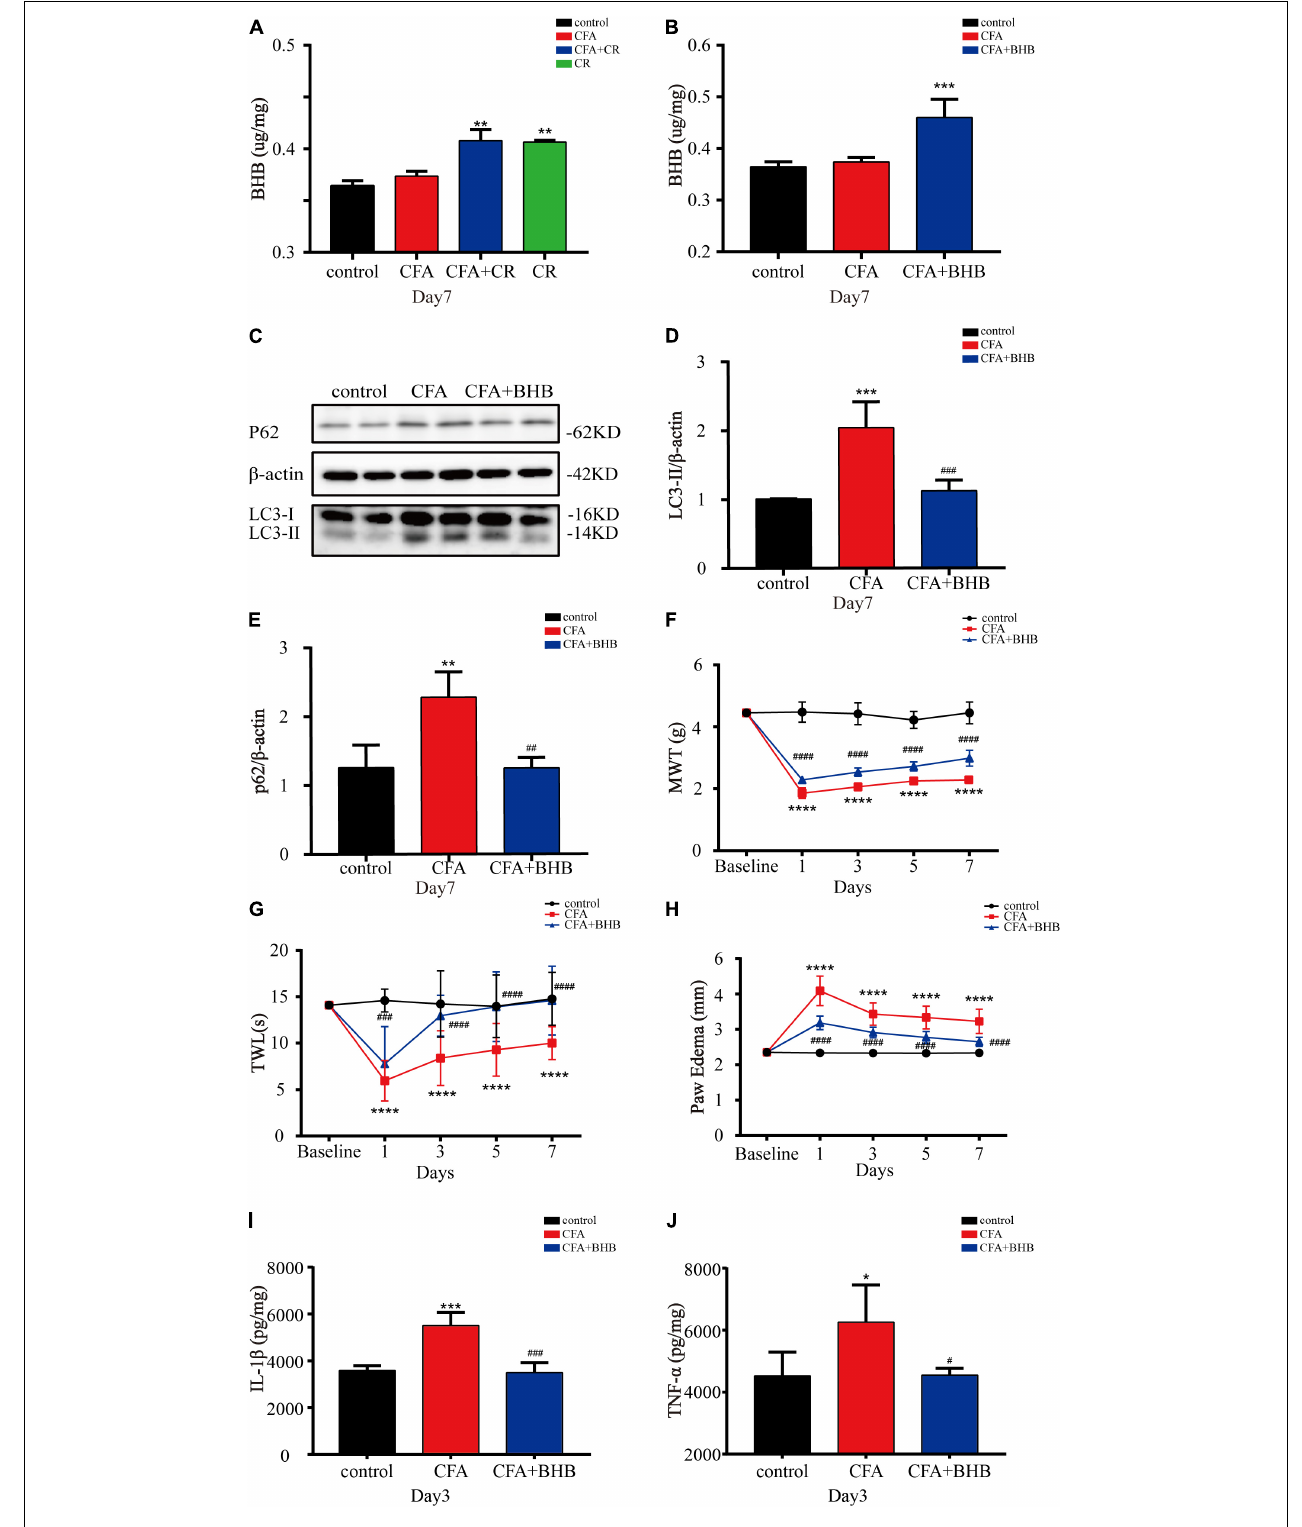
FIGURE 5 | β -Hydroxybutyric acid controls the beneficial effects of CR. (A) BHB levels in the spinal cord of mice in the control, CFA, CFA + CR and CR groups. (B) BHB levels in the spinal cord of mice in the control, CFA, and CFA + BHB groups after BHB injection. Values are expressed as the mean ± SD and were analyzed by